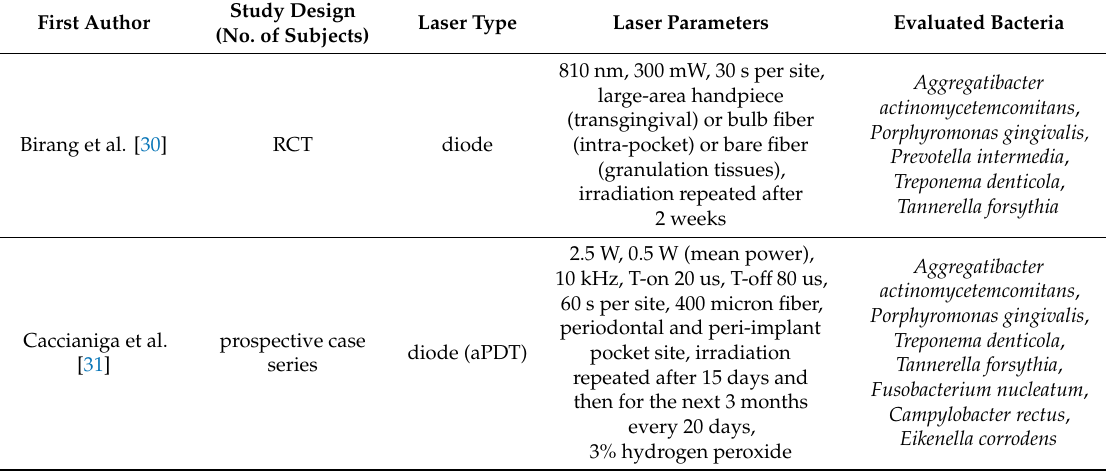
Table 4. General characteristics of the included